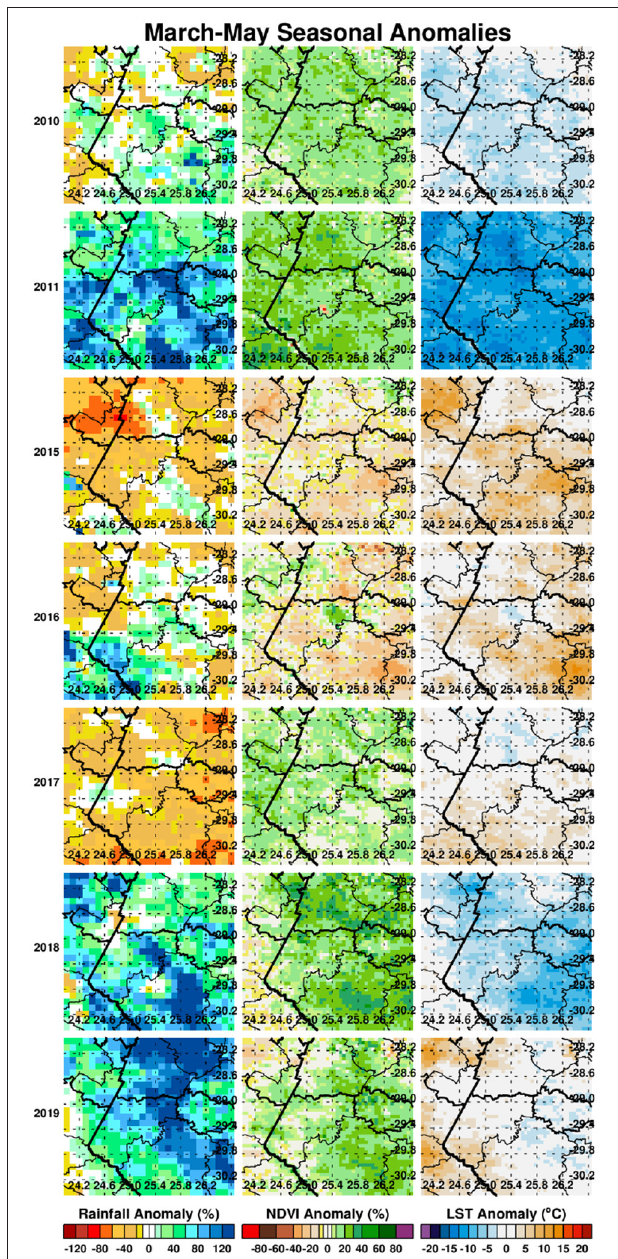
FIGURE 3 | Seasonal anomaly patterns of rainfall, normalized difference vegetation index, and land surface temperatures for epizootic seasons (2009/2010, 2010/2011) and study post-epizootic/interepizootic period seasons from 2014–2019. Seasons are defined by early (September–November: SON), mid (December–February: DJF), and end (March–May: MAM). Rainfall and normalized difference vegetation index anomalies are expressed as percentage departures while land surface temperatures are expressed as absolute departures from the respective seasonal long-term